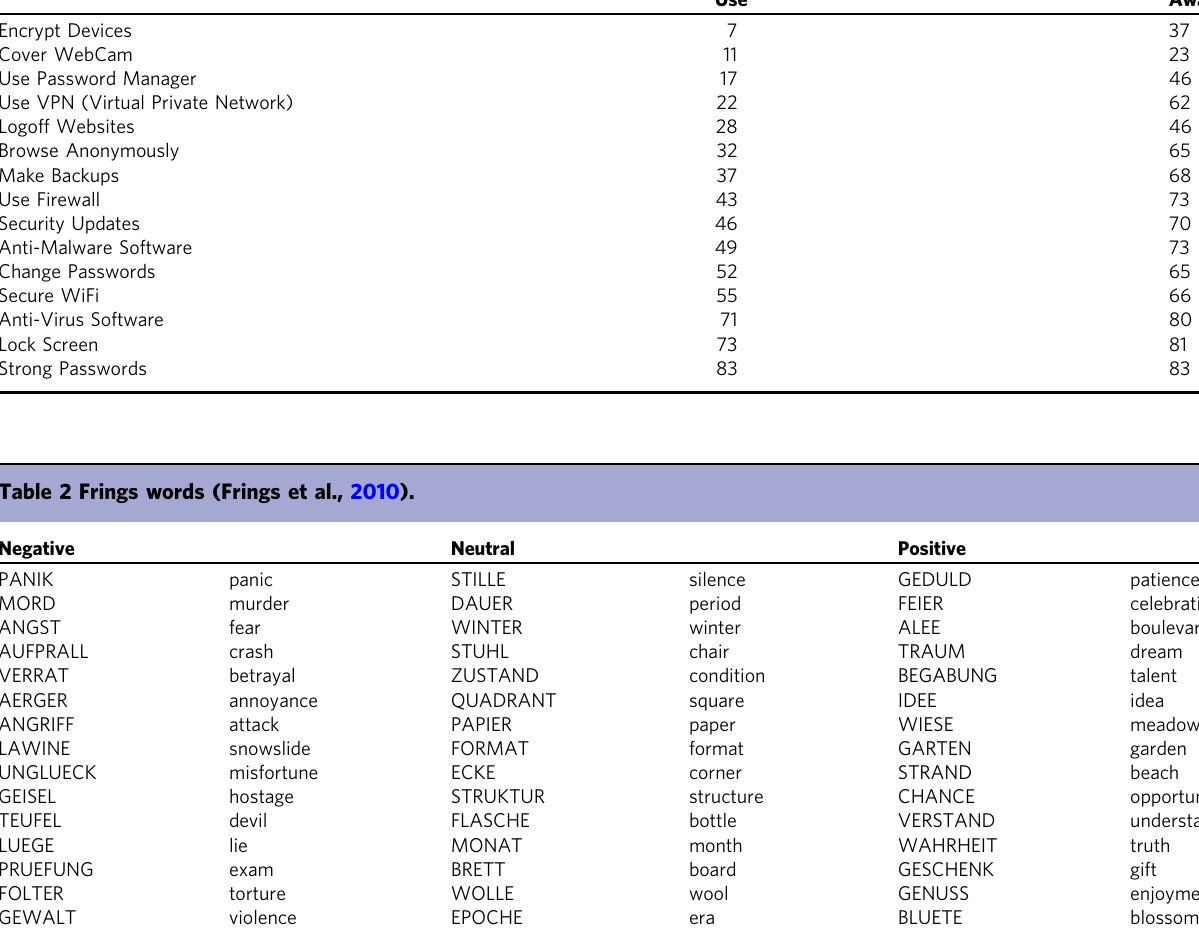
Table 1 Testing awareness and usage of precautions.